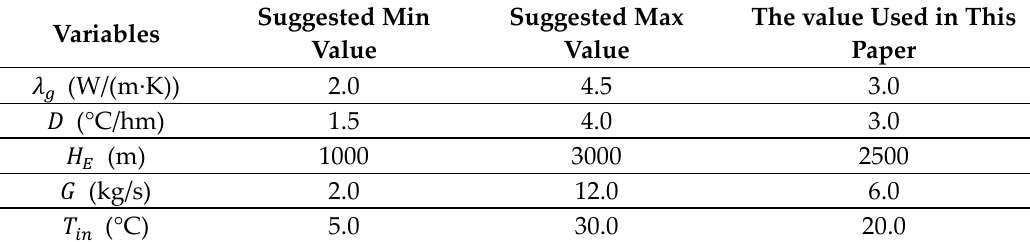
Table 6. The ranges of each independent